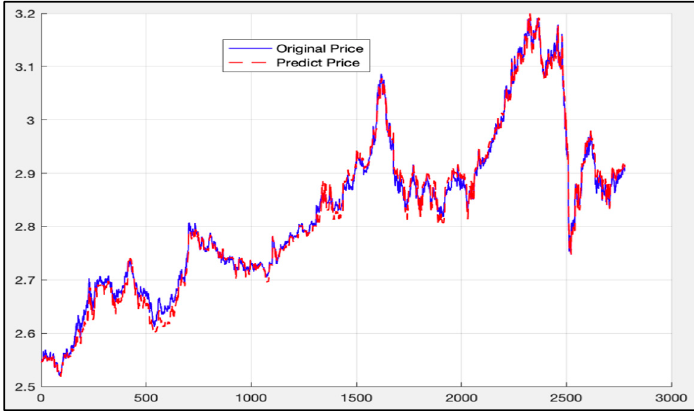
Figure 17. Comparison of Random Forest (RF) prediction results with actual results (8500th data to 11,300th data).